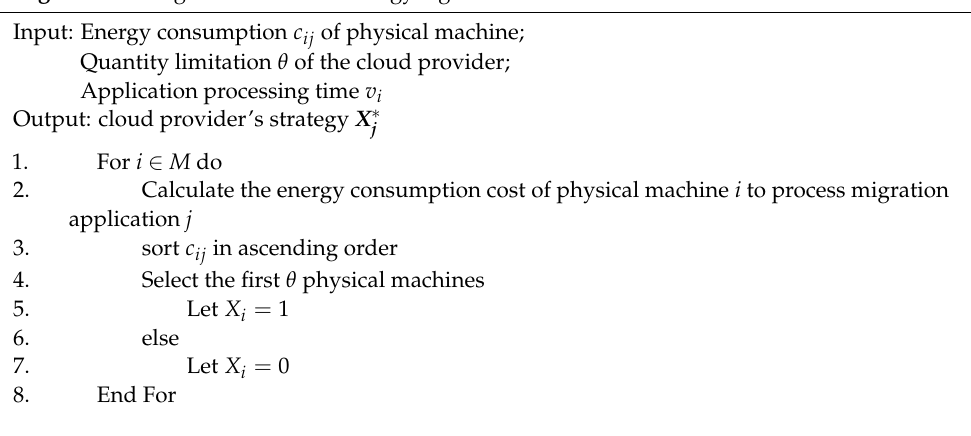
Algorithm 1 Single-round static strategy